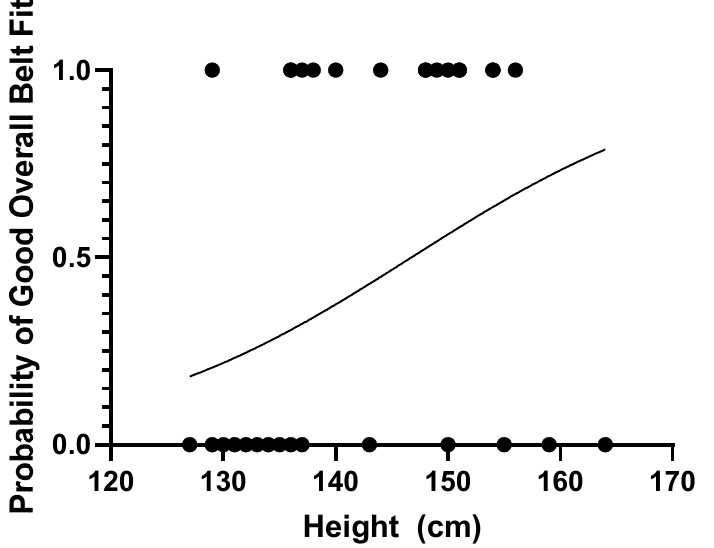
Figure 3. Probability curve for overall good seat belt fit by height of the child. Data points (circles) indicate heights of cases that achieved (1) and did not achieve (0) good overall seat belt fit.